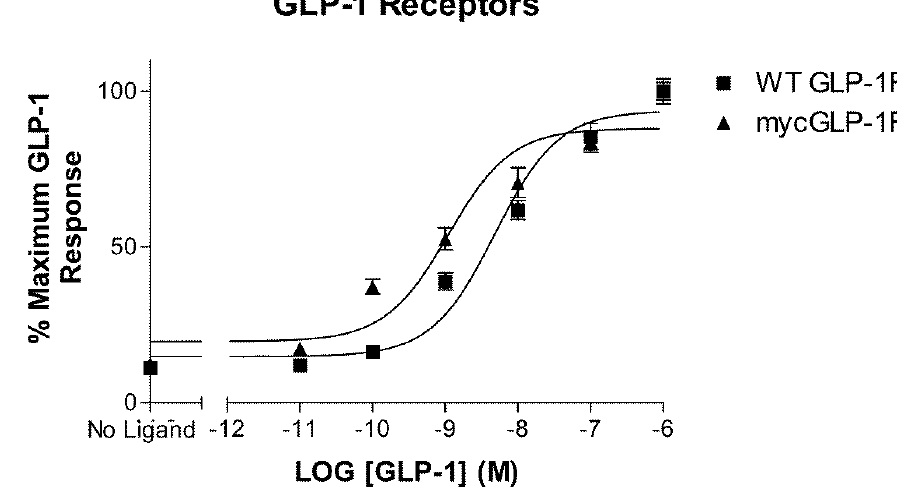
Figure 1. Concentration-response curves for glucagon-like peptide-1 (GLP-1) at wild-type (WT) and myc-tagged GLP-1 receptor (mycGLP-1R) transiently expressed in HEK-293 cells. The curves represent one of at least three independent experiments, and each point represents the mean of triplicates, with the S.E.M. displayed as error bars. Counts were normalized to the maximum GLP-1 response.